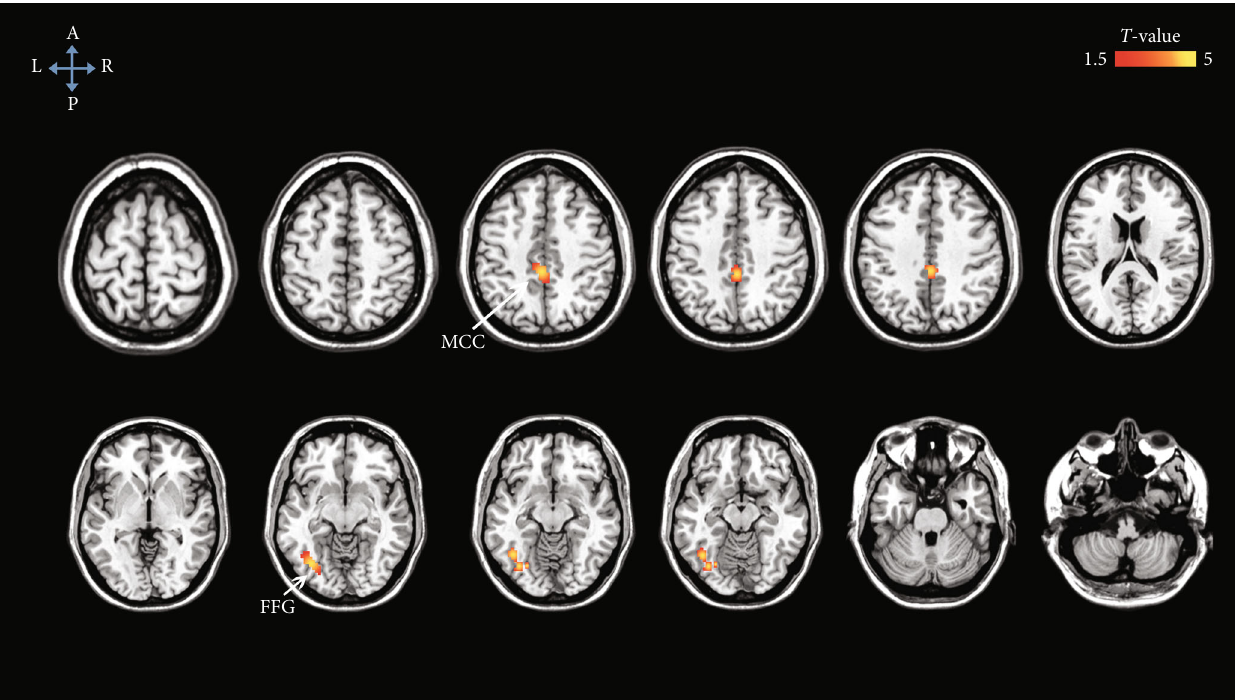
Figure 2: Brain regions exhibiting higher preoperative ALFF values in the DNR patients compared to those in the non-DNR patients, after adjusting for age, sex, education duration, and preoperative cognitive function. The statistical threshold was set at an uncorrected voxel P < 0 : 001 and a corrected cluster P < 0 : 05 (cluster-based FDR corrected). ALFF: amplitude of low-frequency fl uctuations; DNR: delayed neurocognitive recovery; FDR: false discovery rate; FFG: fusiform gyrus; MCC: middle cingulate